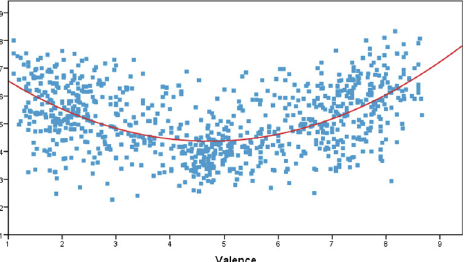
Fig 1. Quadratic distribution of scores for the 875 words in the affective space defined by dominance and valence, for the total sample.